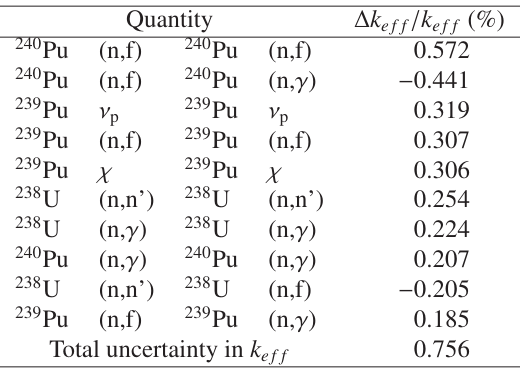
Figure 1. ALFRED core model. Table 1. k ef f uncertainty quantification for ALFRED with JEFF-3.3.